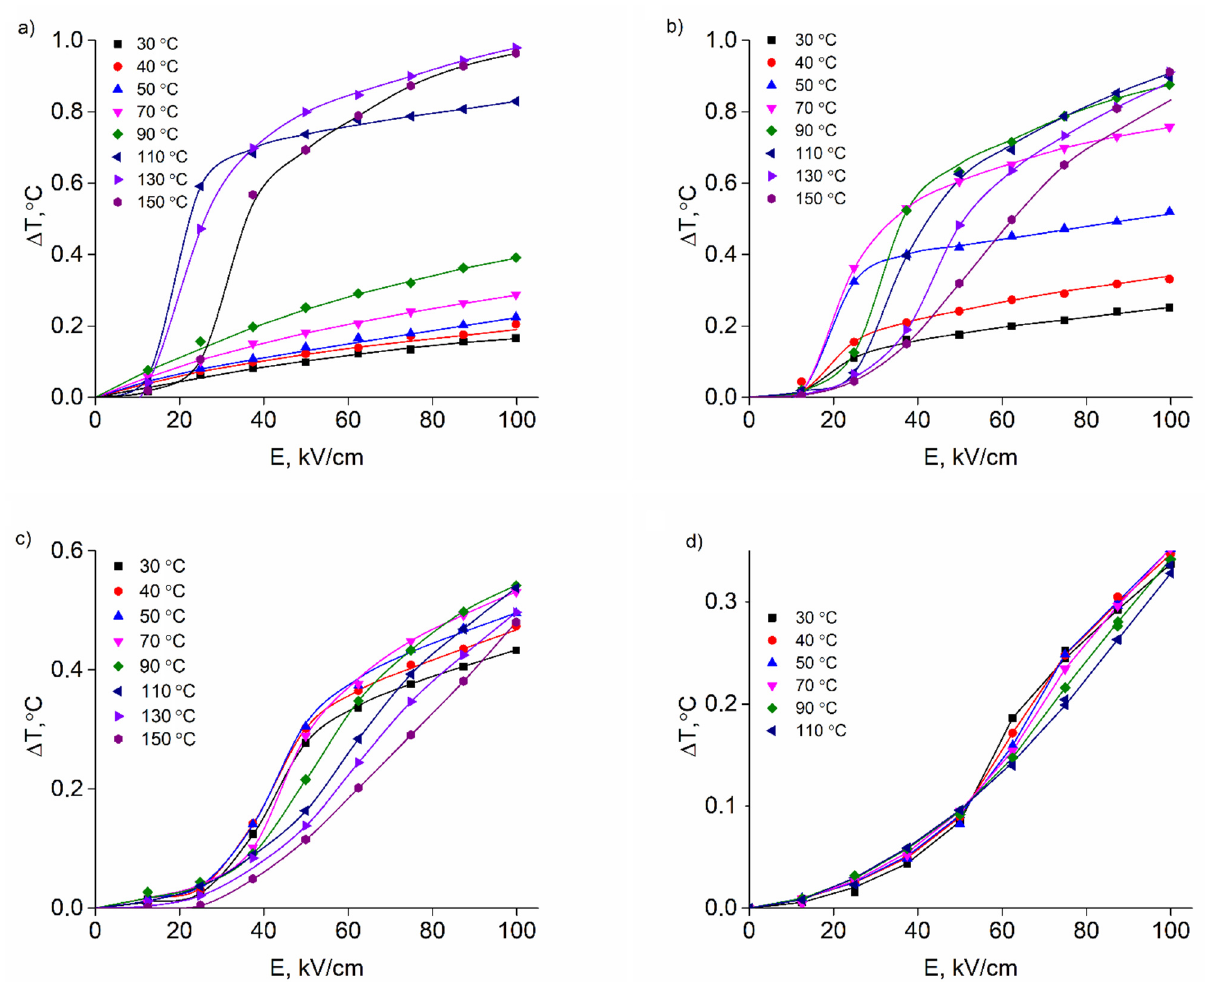
Figure 5. Δ T(E) for (1 − x)(0.8NBT-0.2BT) − xCT compositions with x = 0.050 ( a ), x = 0.075 ( b ), x = 0.100 ( c ), and x = 0.125 ( d ), measured at different temperatures in the case when electric field pulse is switched off.